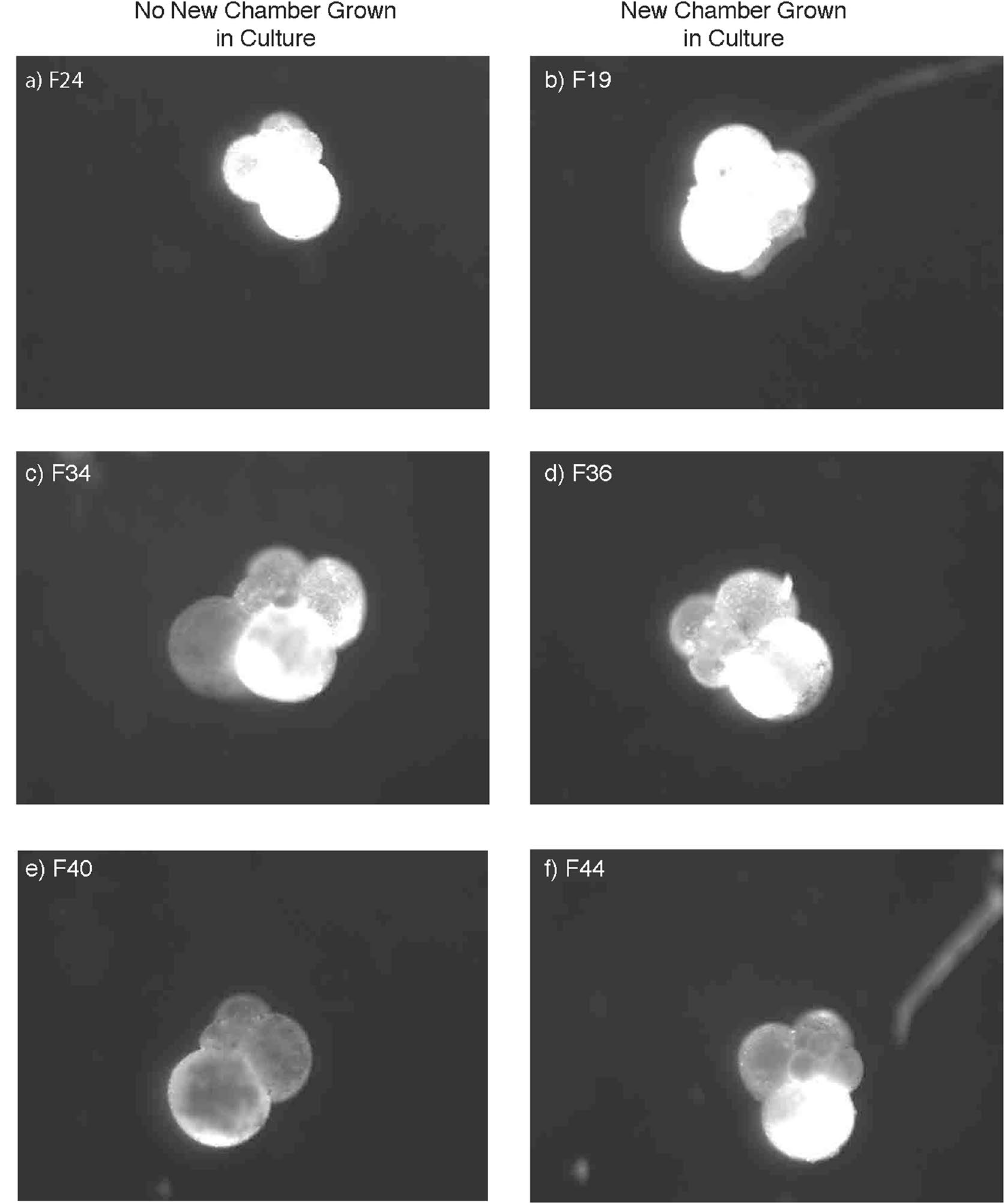
Figure 2. Patterns of calcein incorporation from Globigerina bulloides in culture. Several examples of the different patterns in shell calcification seen from foraminifera collected on the same date. Individuals F24 ( a ), F34 ( c ), and F40 ( e ) did not form a chamber in culture, although calcification occurred over the entire shell in F24, was focused on select chambers in F34 and was minimal in F40. Foraminifera F19 ( b ), F36 ( d ), and F44 ( f ) all grew a chamber with F19 showing calcification in both the new chamber as well as over the rest of the shell, F36 calcified most heavily in the new chamber and less over the rest of the shell, and F44 calcified primarily in the new